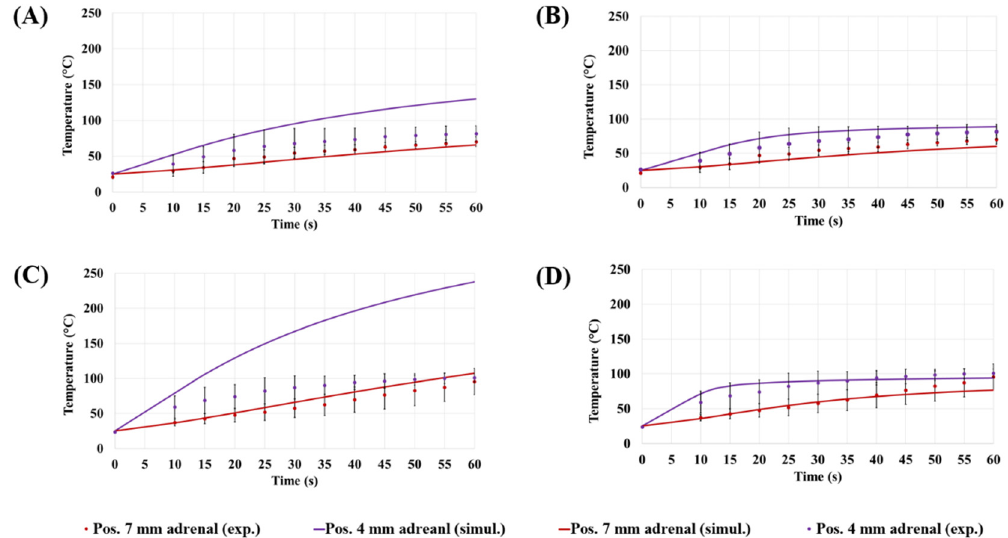
Figure 8. Comparison between the numerical results (solid lines) obtained in the case of standard BHE ( A , B ) and implementing the model of water vaporization ( C , D ). The increments of temperature were considered for two input powers: 30 W ( A , B ) and 60 W ( C , D ) and at distances from the MW applicator equal to 4 mm and 7 mm. Mean and standard deviation of the temperature values measured with fiber optic sensors were also reported (markers).